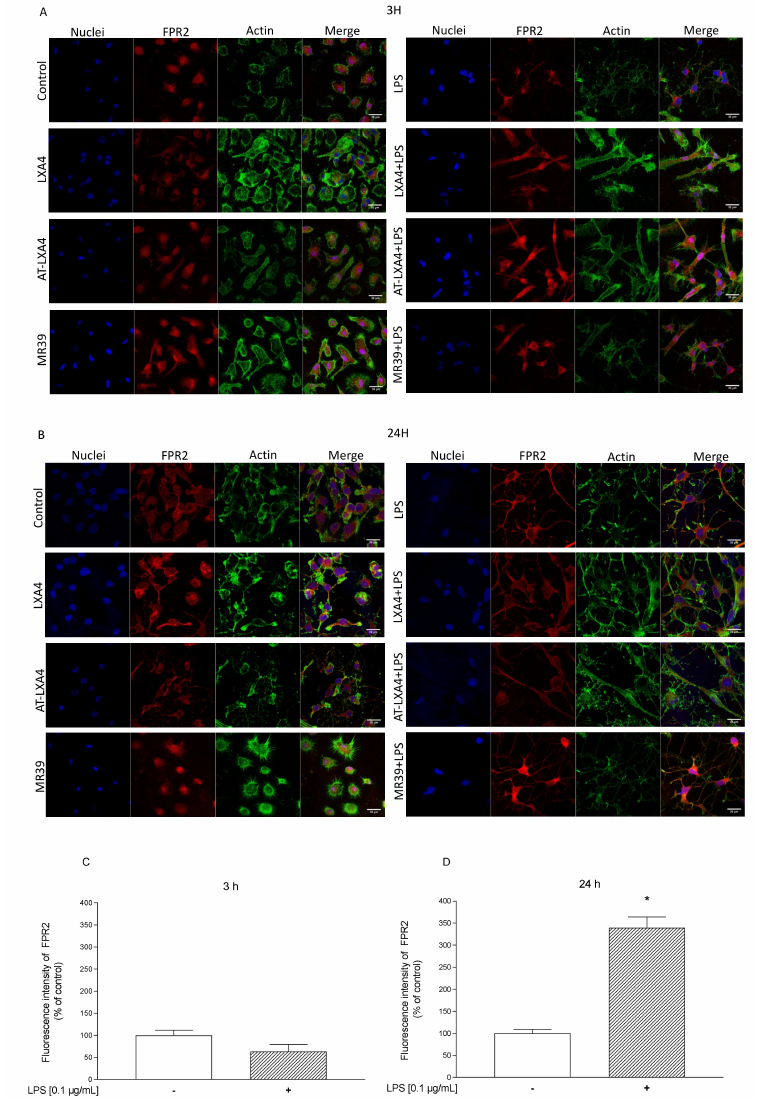
Figure 5. Representative fluorescence images of microglial cells acquired by confocal microscopy 3 h ( A ) and 24 h ( B ) after FPR2 agonists ((LXA4 (0.1 µ M), AT-LXA4 (0.1 µ M), or MR-39 (1 µ M)) and/or lipopolysaccharide (LPS; 0.1 µ g/mL) stimulation. Fluorescence intensity of the FPR2 receptor was calculated from images recorded with the use of a fluorescent confocal microscope. Data are derived for control microglia and microglia activated by LPS after 3 h ( C ) and 24 h ( D ) of treatment. Bars present the mean intensity value normalized to the control ± SEM. Nuclei appear in blue, FPR2 in red, and AlexaFluor 488-labeled phalloidin for F-actin in green. Scale bar: 20 µ m is located in the bottom right corner of each image. * p < 0.05 vs. the control